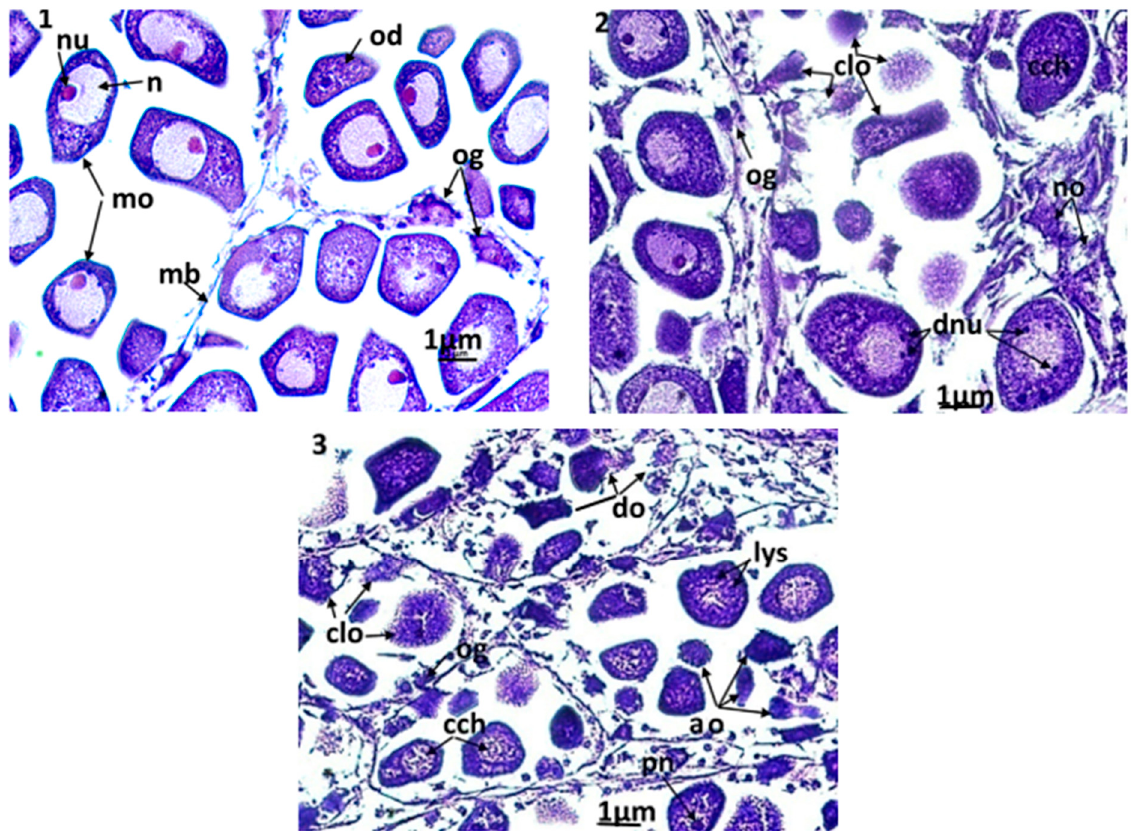
Figure 6. Microphotographs of the female gonad (×400). ( 1 ): control clams, the acini are filled with normal mature oocytes; ( 2 ): clams exposed to triclosan (C2), ( 3 ): clams exposed to triclosan (C3). ao: apoptotic oocytes; cch: condensation of chromatin; clo: cytolysis of oocytes; do: degeneration of oocytes; dnu: nucleolic division; lys: lysosomes; mo: mature oocyte; n: nucleus; no: necrotic oocyte; nu: nucleolus; od: oocyte in development; og: ooogonia; pn: pyknotic nucleus.